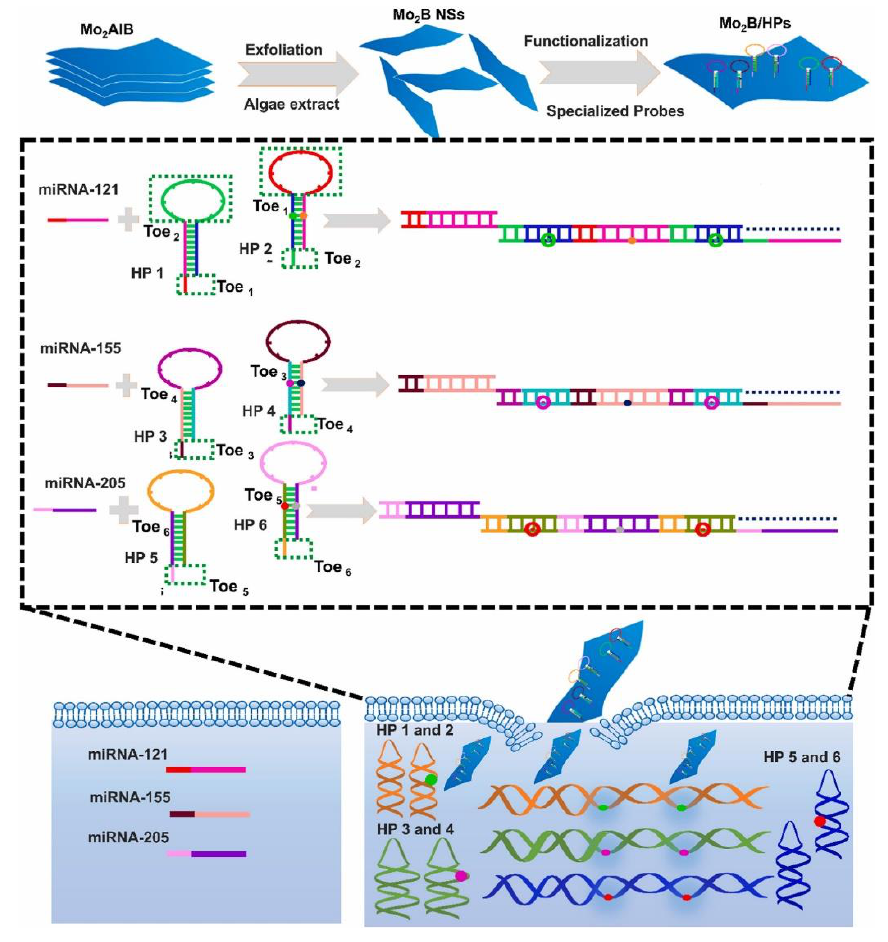
Figure 4. Schematic representation of a fluorescence-quenching platform based on Mo 2 B nanosheets for imaging multiple miRNAs in living cells utilizing HCR amplification. Reprinted with permission from Ref. [72]. Copyright 2022, Elsevier.